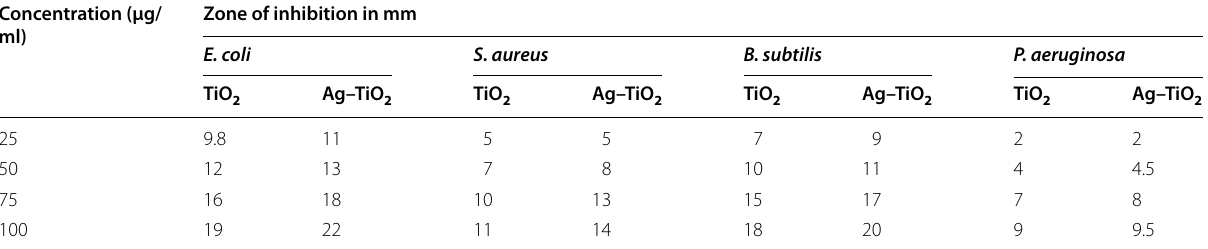
Table 1 Zone of inhibition (mm) at different concentrations of green-synthesised Ag–TiO against Gram-positive and Gram-negative